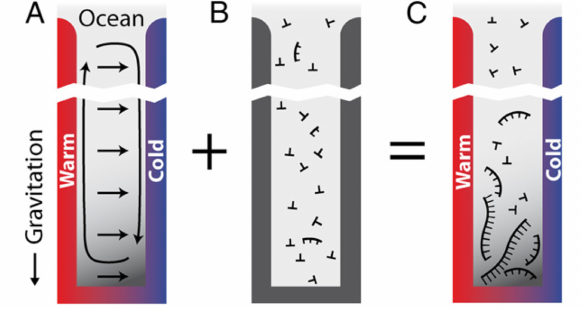
Figure 6. Accumulation of long RNA oligomers in a pore, driven by a thermal gradient. From Ref.